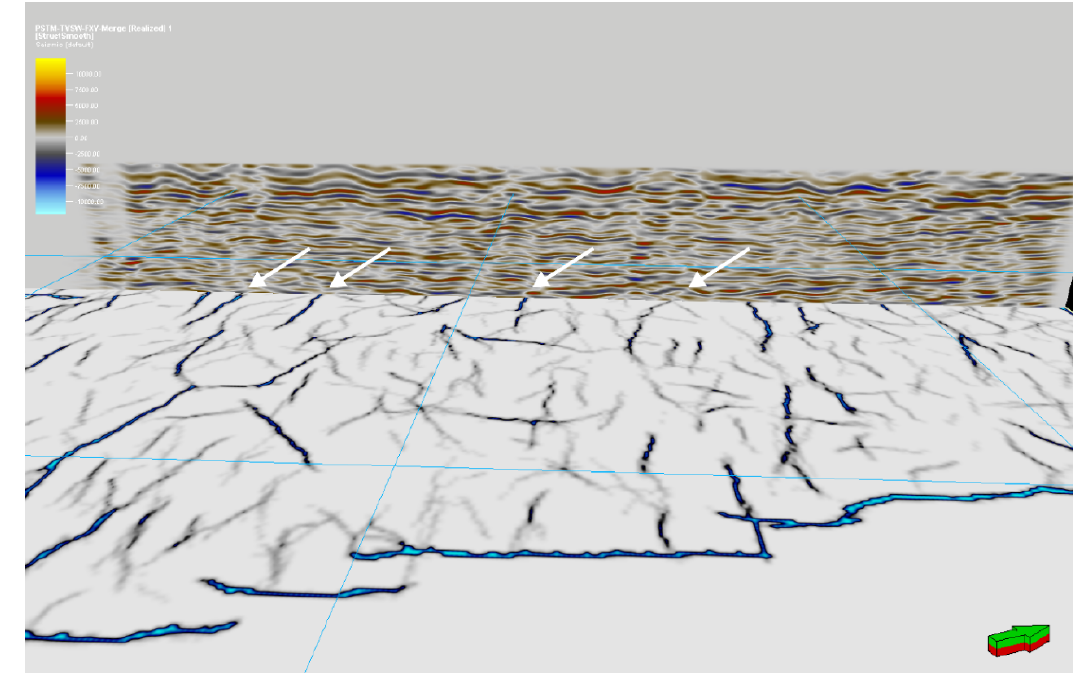
Figure 9. In the 3D window, we QC to validate the fractures in the time slice (–380 msec) and seismic profile – 465 (strike line). The white arrows point to fractures visible in the seismic amplitude vertical section corresponding to fractures predicted in the ant-tracker time slice.